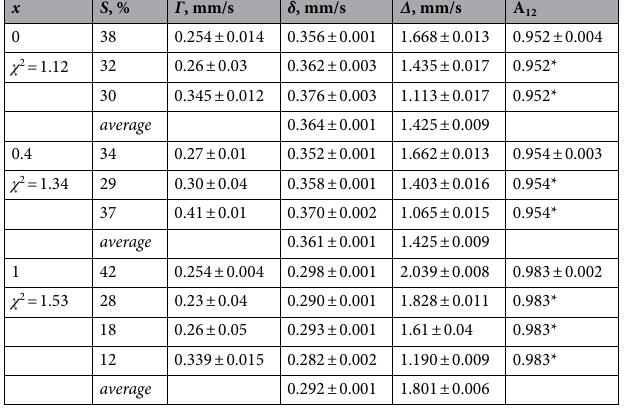
Table 2. Parameters of doublets used to fit to Y x Gd 1−x Mn 0.97 Fe 0.03 O 3 Mössbauer spectra at room temperature: S is relative area, Γ —linewidth, δ— isomer shift relatively to α-Fe at room temperature, Δ—quadrupole splitting, A 12 — line area ratio. *All